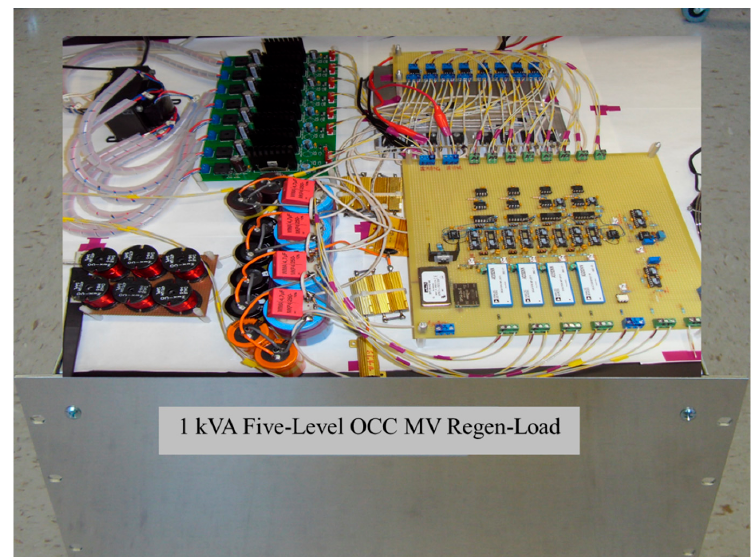
Figure 14. 1kVA five-level OCC MV Regen-Load prototype.